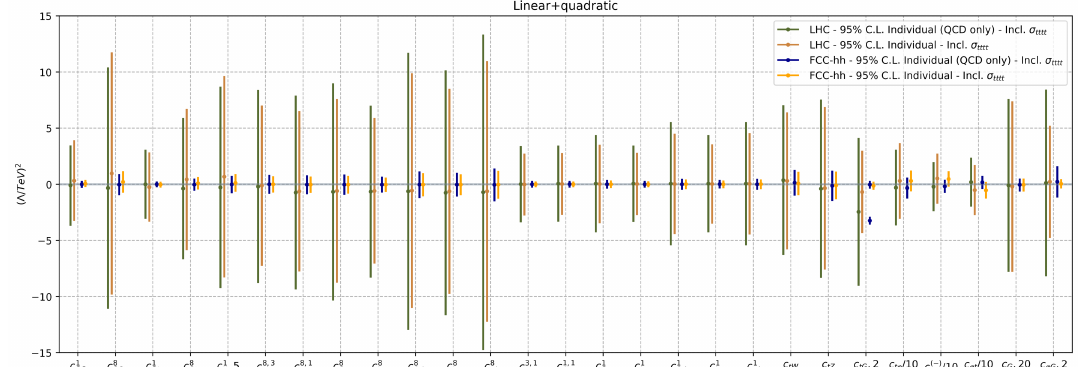
Figure 20 . Limits on all four-fermion and relevant operators used in this study obtained from the χ 2 fit to the ATLAS [47] and CMS [48] inclusive measurements and using the SM prediction of ref. [2] as well as FCC-hh